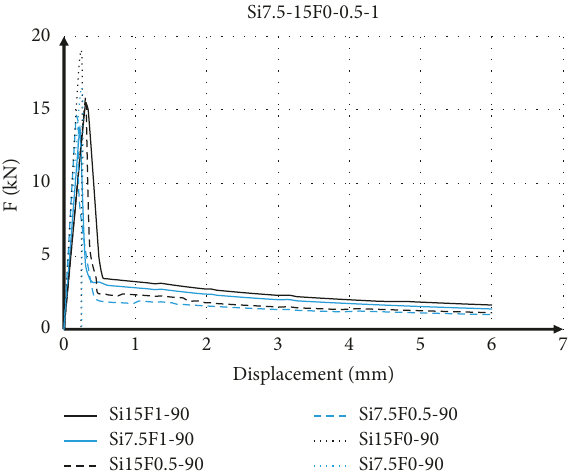
Figure 9: Effect of MPW fiber on flexural behavior of concrete containing silica fume at 90